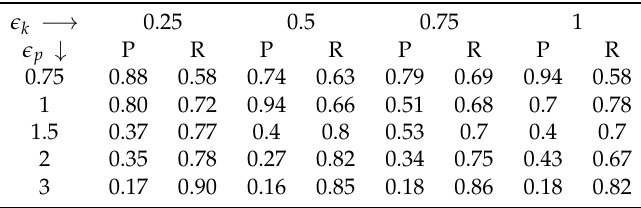
Table 4. Precision and Recall values for sequence of Scene